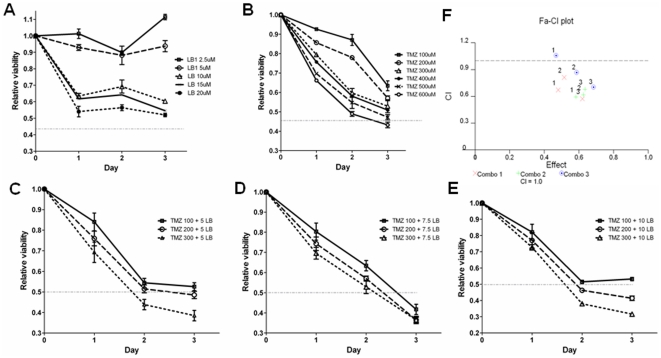

In vitro anti- proliferative activity of LB1 and TMZ and their combination.Inhibition of growth of MPC cells in culture: (A and B) Exposure for 3 days to increasing concentrations of LB1 or TMZ. (C–E) Exposure to increasing concentrations of LB1 plus TMZ. (F) Synergy analysis was done based on data from (A–E) using CalsuSyn software. CI values: C = 1 as additivity; C<1 as synergy; C>1 as antagonism. Combo 1 presents combination of 5 µM of LB1 and 100, 200, 300 µM of TMZ; Combo 2 presents combination of 7.5 µM of LB1 and 100, 200, 300 µM of TMZ; and Combo 3 10 µM of LB1 and 100, 200, 300 µM of TMZ.